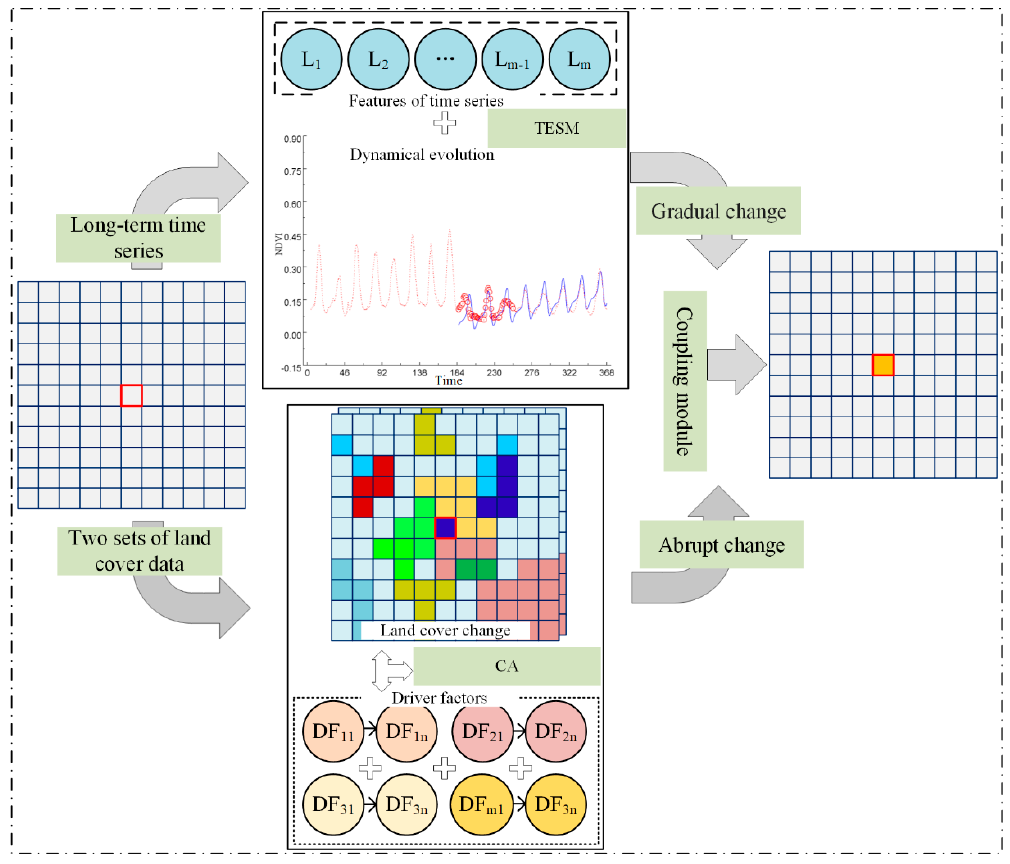
Figure 1. The framework of the temporal dimension extension cellular automaton (TDE-CA). L and DF are the features and driving factors, respectively, used in the temporal evolution simulation module (TESM) and the CA (cellular automata) module.